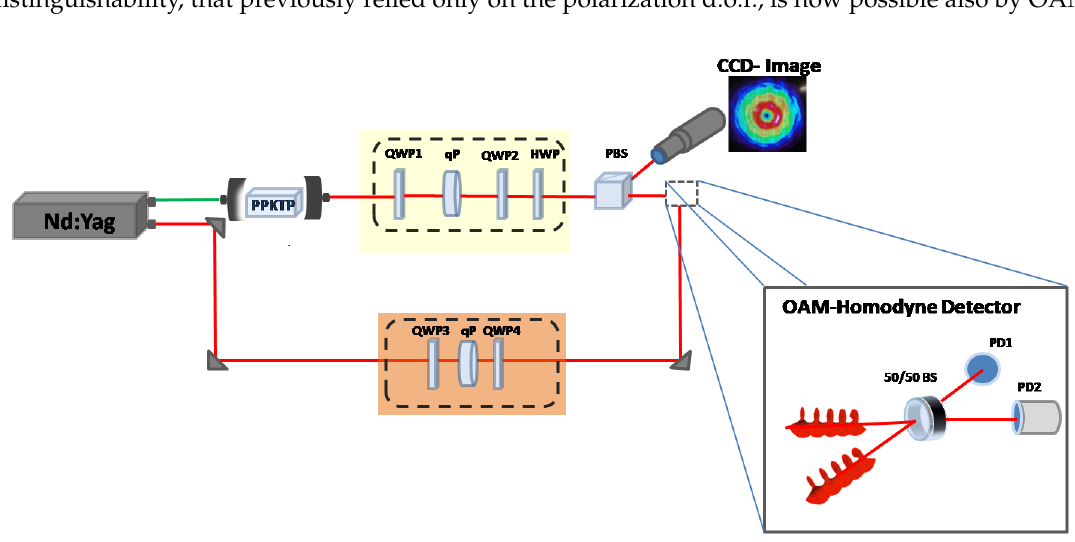
Figure 1. Schematic of the experimental set-up. The second-harmonic output of a CW Nd:Yag laser, internally frequency doubled, is used as pump for an OPO based on a α -cut PPKTP type-II crystal that generates a pair of frequency-degenerate orthogonally-polarized modes. The OPO threshold is ≈ 70 mW and it is operated at ≈ 70% of the threshold value. The yellow shadowed area including two quarter-wave plates (QWP1 and QWP2), a q -plate (qP) and a half-wave plate (HWP), represents the branch designed to manipulate the polarization and the OAM of the entangled beam. A similar set of optical components is employed along the LO branch to directly homodyne helical modes (dark orange shadow). The bottom-right inset shows an enlarged view of the homodyne